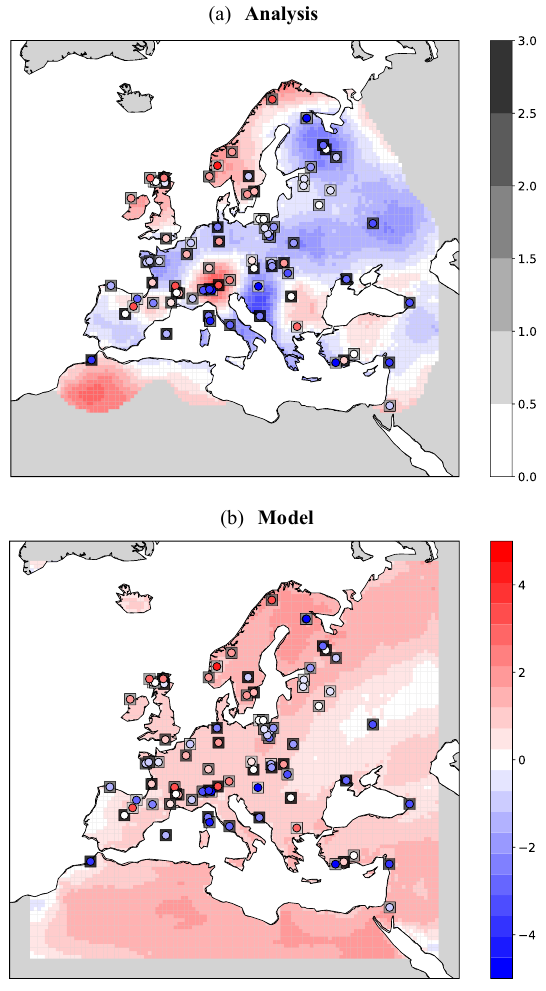
Figure 15. DA results of T2M during summer at 6KBP using weighted arithmetic mean by time distances: (a) analysis values along with the testing observations (circles) and their standard error (squares). Values with an error covariance of analysis greater than 0.9 are masked out from analysis and (b) the model